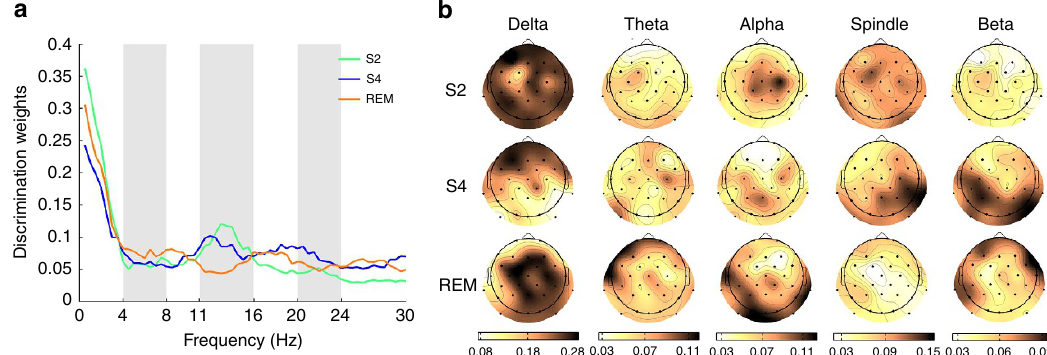
Figure 5 | Frequency contributions to memory reprocessing in NREM and REM sleep. ( a ) Discrimination weights show that in NREM sleep stages S2 and S4 spindle activity in the frequency range between 11 and 16Hz is predictive for learning content. In REM sleep, theta, alpha and higher beta frequencies contributed more to correct classification. Slow frequencies o 4Hz were informative in all sleep stages. ( b ) The topography of predictive channels clearly differs between NREM and REM sleep. In NREM sleep stage S2, mainly delta and spindle frequencies contributed to correct classification. Similarly, frontal delta power and right parieto-temporal spindle activity were most informative for classification during NREM sleep stage S4, together with posterior higher frequency activity. REM sleep shows a more complex pattern. Here slow oscillations of central electrodes and frontal and temporal theta as well as occipital alpha contributed most to discrimination between learning